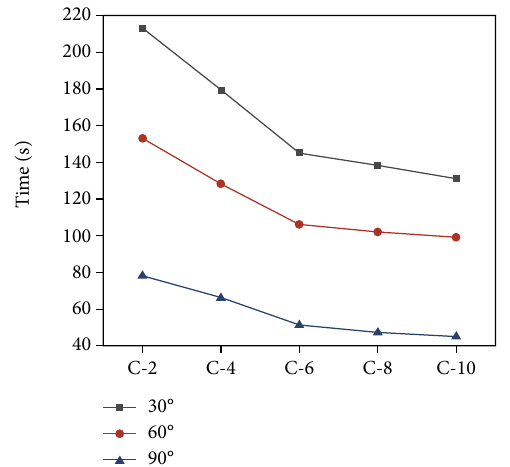
Figure 11: The relationship between ice falling time and the number of coating layers under di ff erent inclination